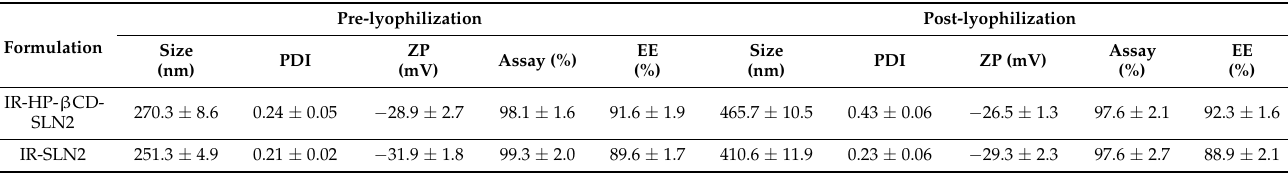
Table 6. Pre- and post-lyophilization effect on physicochemical characteristics of the optimized IR-SLN and IR-CD-SLN formulation (mean ± SD, n =